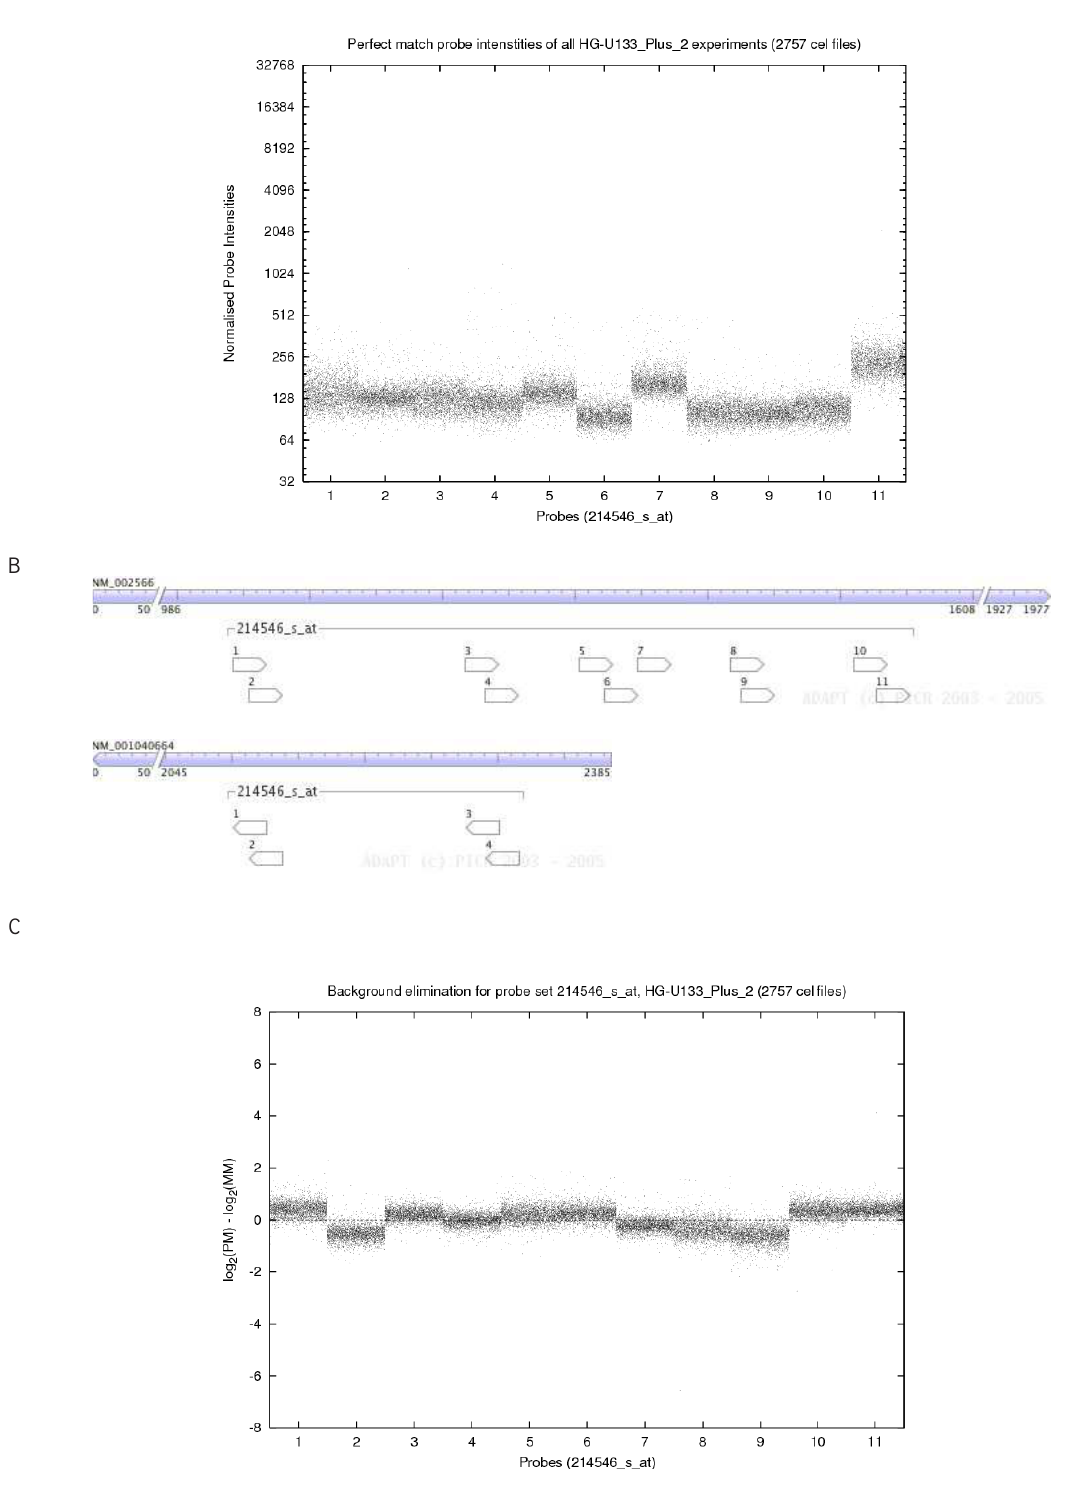
Supplementary Figure 5: Probe intensities over all cel files for probe set 214546 s at on the HG U133 Plus 2 array (A) Perfect match intensities (log scale) (B) ADAPT probe positions on the transcripts (C) Background elimination (log 2 (PM) - log 2